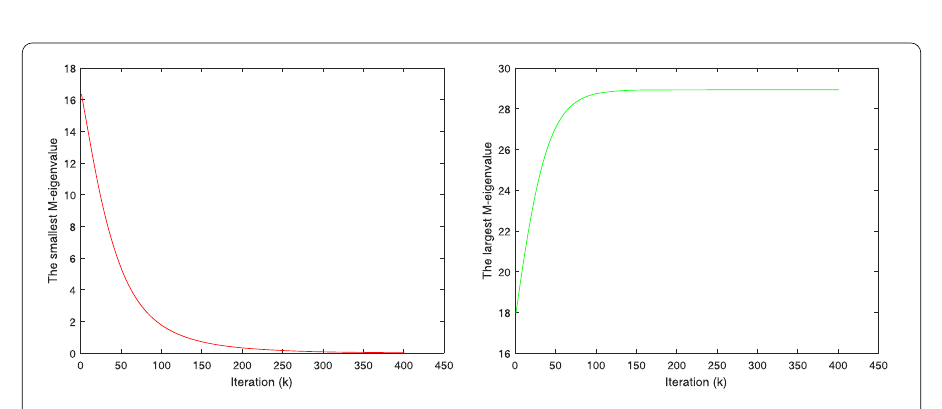
Figure 4 Numerical result of Example